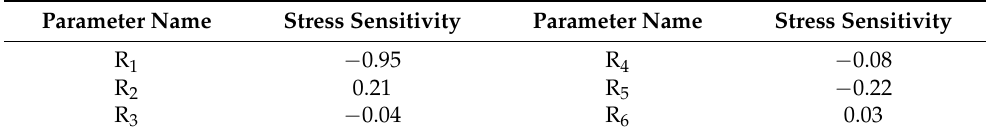
Table 4. Sensitivity analysis of stress to plate thickness.